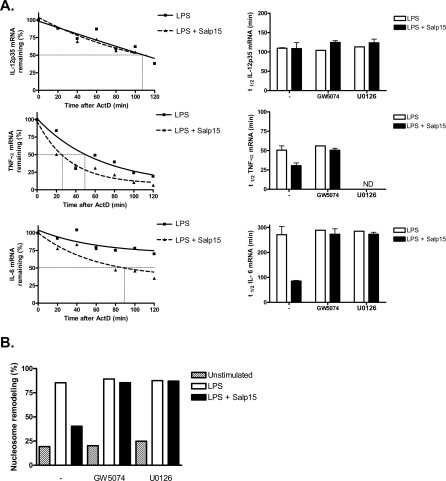
Salp15 Destabilizes IL-6 and TNF-α mRNA and Impairs Nucleosome Remodeling at the IL-12p35 Promoter(A) Salp15 destabilizes IL-6 and TNF-α mRNA. DCs were stimulated with Salp15 and LPS for 6 h. Actinomycin D (ActD) was added to block new mRNA synthesis. Cells were harvested for 2 h to determine mRNA half-life. IL-12p35 mRNA stability remained unaltered in the presence of Salp15, whereas IL-6 and TNF-α mRNA half-life was strongly reduced. This was completely restored using Raf (GW5074) or MEK (U0126) inhibitors. Bars represent the mean of two independent experiments ± SE. ND: Not determined.(B) IL-12 inhibition by Salp15 is a result of decreased nucleosome remodeling at the IL-12p35 promoter. Cells were stimulated as described before and harvested. Using enzymatic digestion, nucleosome remodeling was measured by quantitative real time PCR. Results are expressed as a percentage of the remodeling observed in EcoRI-digested samples. The decreased remodeling induced by Salp15 could be completely restored using Raf (GW5074) or MEK (U0126) inhibitors. Results represent results from one donor.